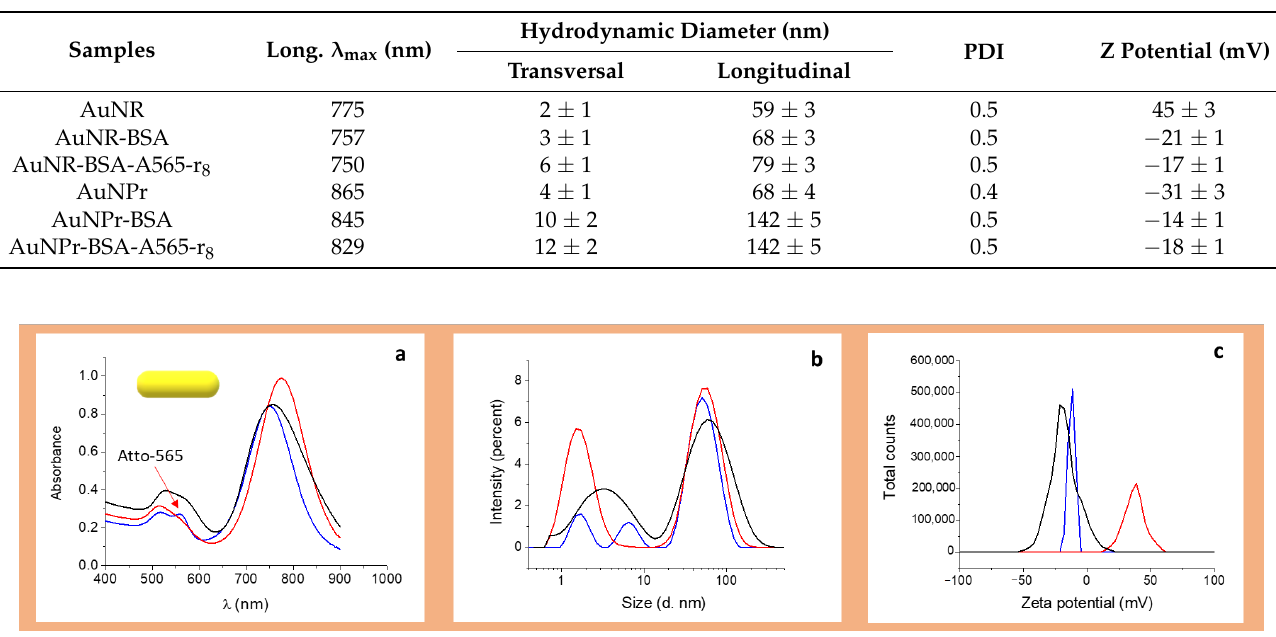
Figure 2. Characterization of BSA-A565-r 8 capped AuNRs: red line, AuNRs, black line AuNR-BSA, blue line AuNR-BSA-A565-r 8 . ( a ) UV-Vis NIR spectra. The red arrow shows the presence of Atto-565. ( b ) Size distribution. ( c ) Zeta potential distribution. Acquired in PBS, pH = 7.